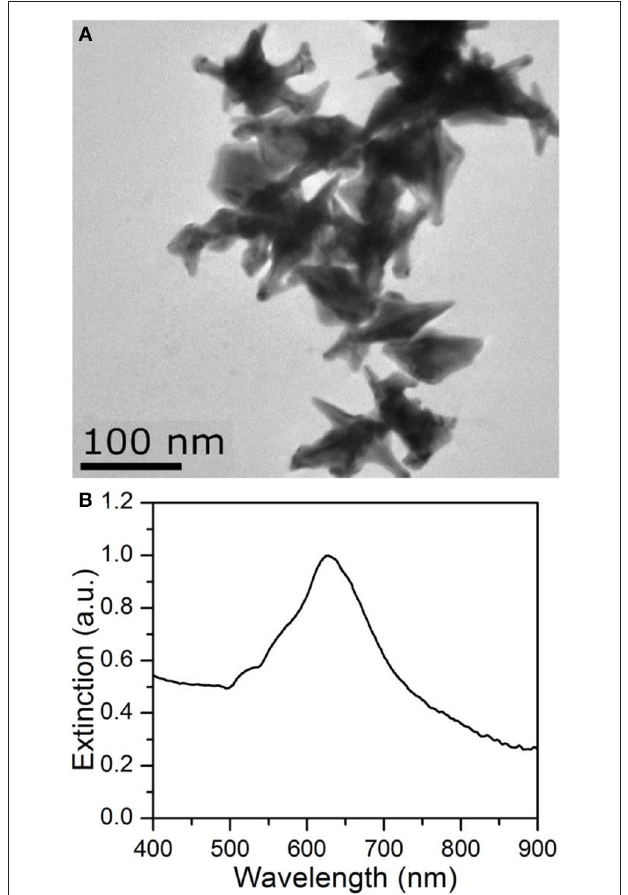
FIGURE 2 | TEM image (A) and the extinction spectra (B) of Au